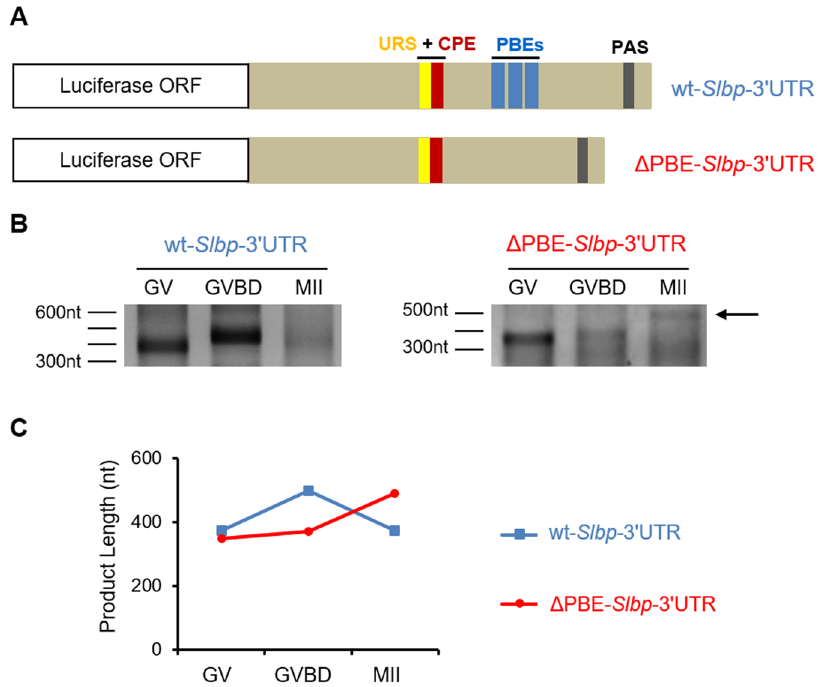
Figure 7. Luciferase- Slbp 3 ′ -UTR constructs and injections. ( A ) The luciferase ORF was ligated either to the wild-type Slbp- 3 ′ UTR (upper construct) or to a mutant Slbp 3 ′ UTR lacking the three putative PBE sequences downstream of the URS-CPE (lower construct). ( B ) mRNA synthesized in vitro was injected into fully grown immature oocytes, which were maintained at the GV-stage or allowed to mature and collected after GVBD or at MII. The length of the poly(A) tail was assessed by RL-PAT using primers that do not amplify cDNA derived from the 3 ′ -UTR of endogenous Slbp mRNA. ( C ) Line graphs show the length of the cDNA products derived from the injected mRNAs. wt-Slbp- 3 ′ UTR shown in blue, Δ PBE- Slbp -3 ′ UTR in red. The experiment was performed 2